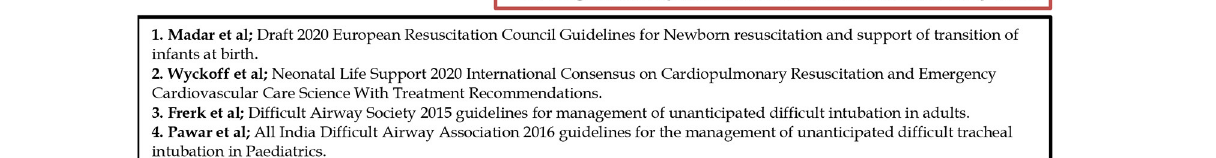
FIGURE 2 | Proposed algorithm for the management of the neonatal unanticipated difficult airway. The red column describes the situation where mask ventilation is difficult and/or impossible to achieve despite measures including the insertion of an oropharyngeal or nasopharyngeal tube, and two-person mask ventilation. The red column is the most time critical. The blue column is the situation where mask ventilation is possible, but the newborn is difficult to intubate, e.g., a semi-vigorous baby where positive pressure ventilation is considered ineffective or prolonged. In this situation there is usually time to reevaluate the initial management plan and reposition the head of the newborn for another intubation attempt with a videolaryngoscope. DR, Delivery Room; FONA, Front of neck access; NICU, Neonatal intensive care unit; SAD, Supraglottic airway device. situations. A difficult airway and intubation can occur anywhere and at any time of the day or night, and the algorithm is not site-specific for use only in the DR or NICU. The red and